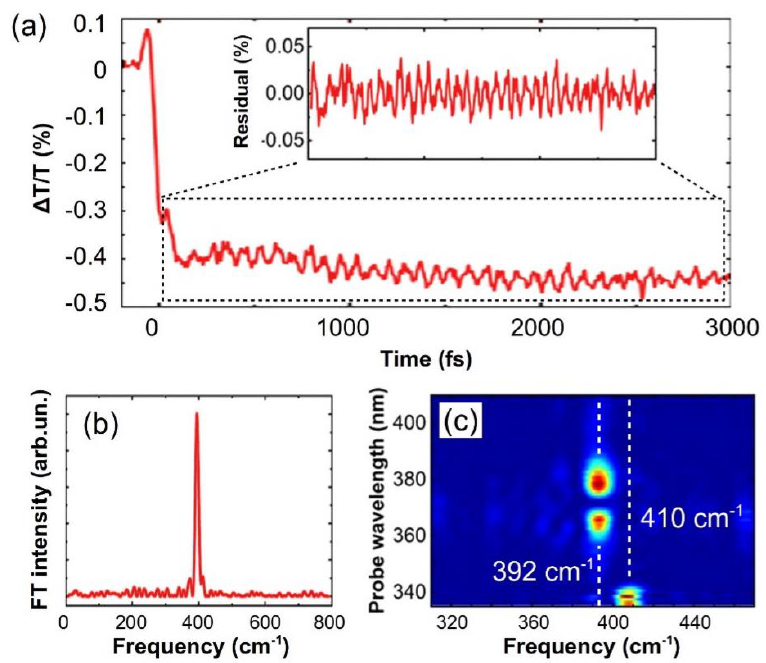
Figure 11. ( a ) Dynamics at 385 nm (main panel) and residuals (inset) after subtraction of a multi-exponential fit; ( b ) Fourier transform of the residual from panel ( a ); ( c ) The Fourier intensity of the oscillatory component as a function of the probe wavelength.